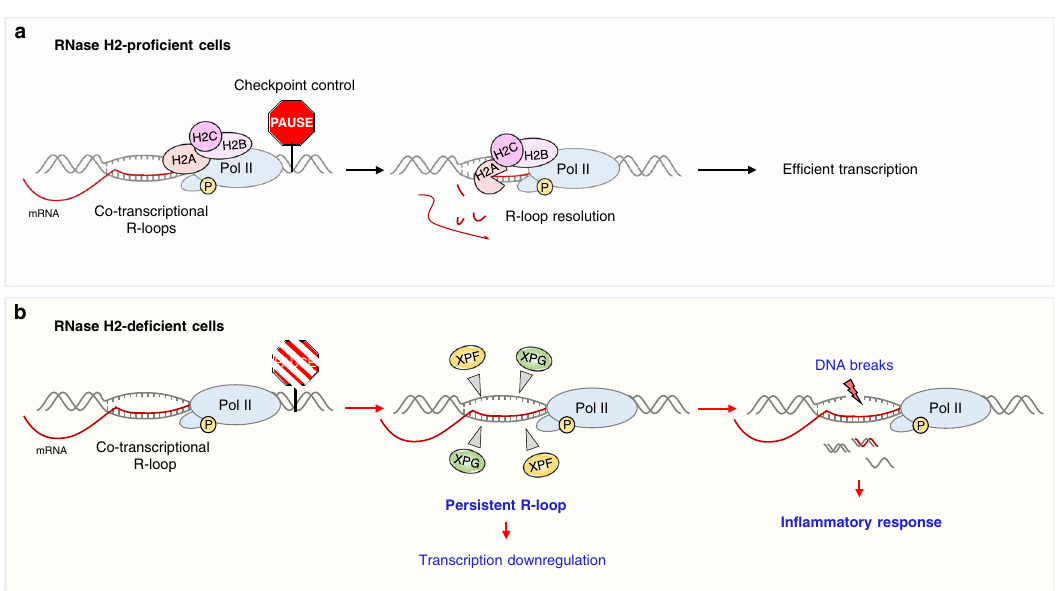
Fig. 6 Model for the role of RNase H2 complex in R-loop resolution during transcription. a RNase H2 binds actively transcribed genes and interacts with phosphorylated Pol II. If co-transcriptional R-loops exceed the physiological levels, RNase H2 resolves them, ensuring a checkpoint control to promote ef fi cient transcription. b Lack of RNase H2 results in the lack of this checkpoint control and accumulation of R-loops at short genes, impaired transcription, XPF- and XPG-mediated R-loop cleavage and consequent DNA break formation which activates an in fl ammatory response, characteristic of AGS (LSM 880; ZEISS). Fluorescence intensity was analyzed with ImageJ (version 1.52p) a ring region around the nuclei and identifying the micronuclei in this region by as described previously 70 . In 96-well plates, nuclei were stained with 1µg/ml using the “ B ” method with Columbus software (version 2.8.2). Antibodies used in this study can be found in Supplementary Information fi le. Hoechst 33342 for 15 min, washed twice with PBS and stored at 4 °C until analysis. 96-well plates were scanned with a 20X objective using an Operetta High-Content 5 ’ -EU labeling . HeLa cells were seeded on coverslips and incubated with 1 mM with Columbus software (version 2.8.2). Data were plotted by using box-and- 5-ethylnyl uridine (EU) for 1 h to label newly synthesized RNA. For automated EU whisker plot with GraphPad Prism 9.1.0 software with the following settings: boxes: analysis HeLa and HEK293T cells were seeded in 96-well plates (CellCarrier; PerkinElmer). 96-well plates were coated with poly-L-lysine (Sigma-Aldrich) for HEK293T. Global nascent RNA transcription was detected using Click-iT RNA Alexa Fluor 488 Imaging Kit (ThermoFisher, C10329) according to the manu- facturer ’ s instructions. Following Click-iT reaction cells were immunostained by incubation with an anti-nucleolin antibody in 2% (v/v) BSA in PBS for 45 min at RT. After two washes, donkey anti-rabbit IgG (H + L) highly cross-adsorbed secondary antibody Alexa Fluor 594 (Life Technologies, A-21207) or goat anti- rabbit IgG (H + L) highly cross-adsorbed secondary antibody Alexa Fluor 647 (Life Technologies, A-21245) was added for 1h at RT and washed two times in PBS. Coverslips were mounted using Fluoromount-G (SouthernBiotech, 0100-01) con- taining DAPI and slides were visualized with an inverted confocal microscope